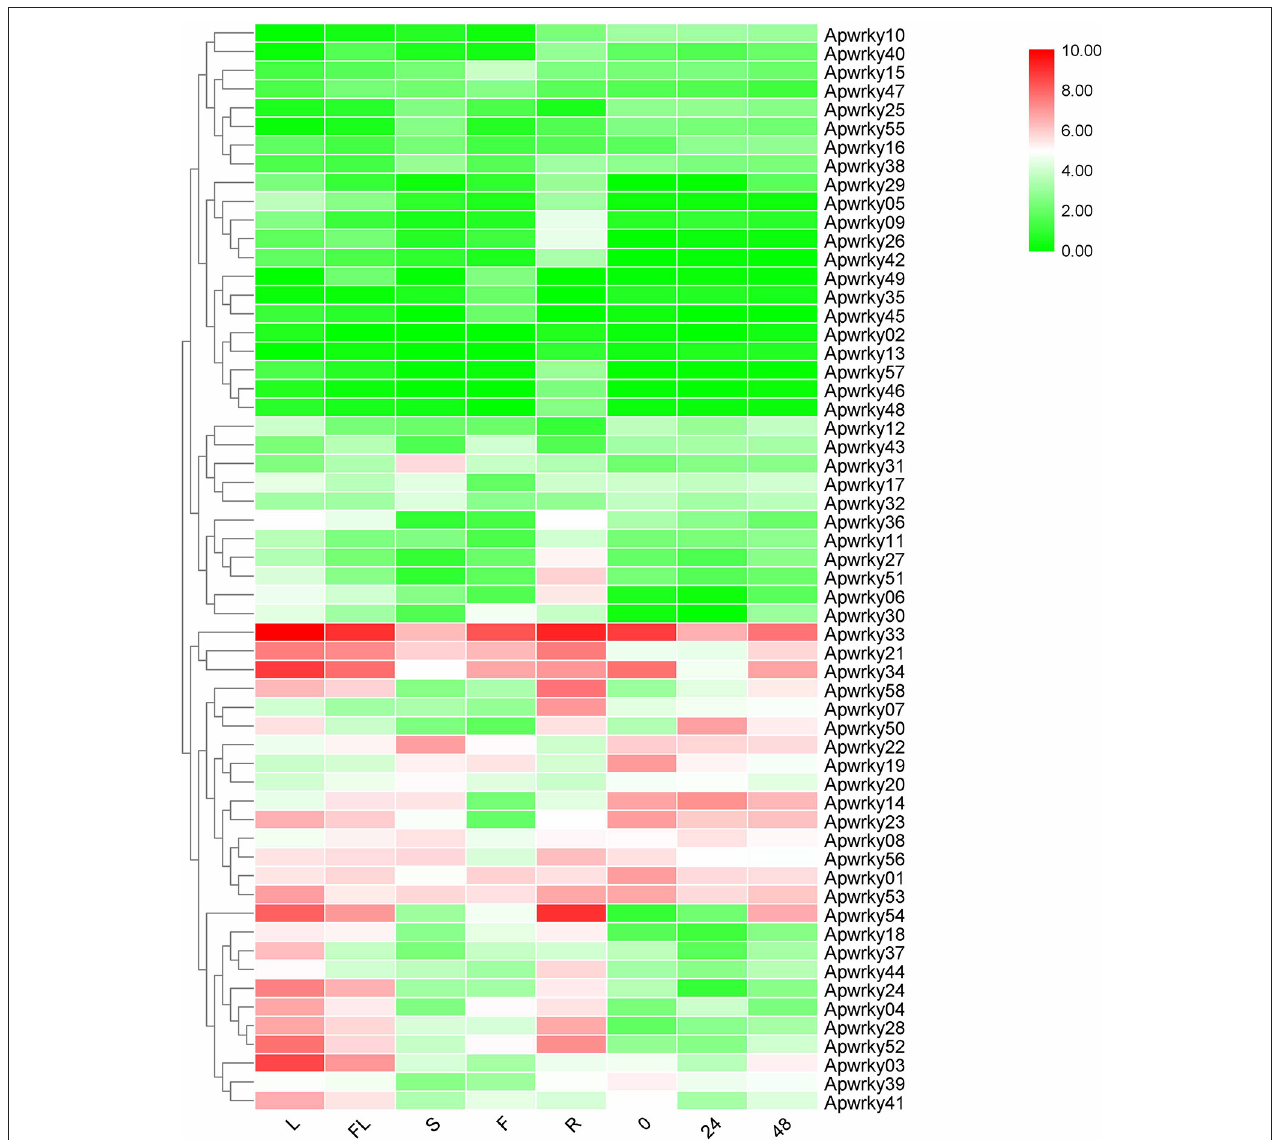
FIGURE 7 | Heatmaps representing the expression profiles of Chuanxinlian ApWRKY genes in leaf, root, stem, flower, fruit and MeJA-treated